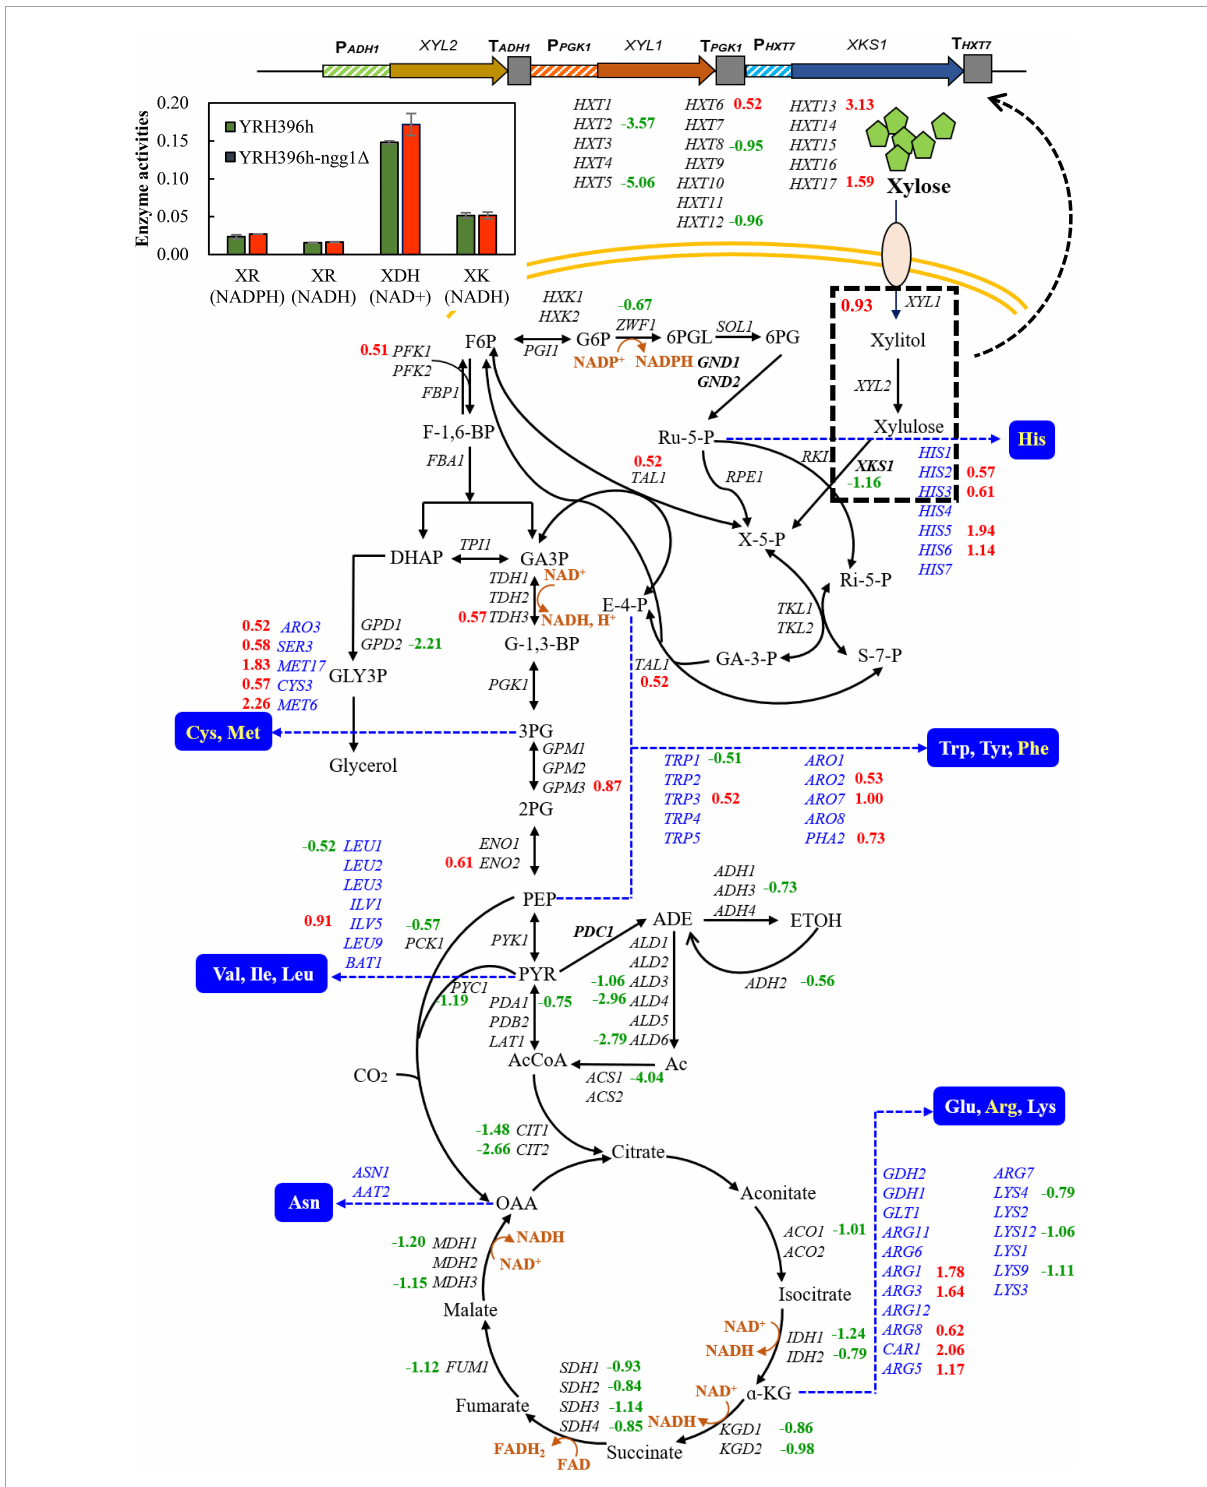
FIGURE4 Differentially expressed genes involved in carbohydrate and amino acids metabolism between YRH396h- ngg1 (cid:49) and YRH396h. Yeast strain with NGG1 deletion and its parent strain S. cerevisiae YRH396h were grown in YPX40 medium consisting of 4 g/L yeast exact, 3 g/L peptone, and 40 g/L xylose, and cells were collected at 48 h for transcriptome analysis. Genes involved in central carbon metabolism and amino acid biosynthesis were presented. The heterogenous xylose metabolism pathway containing XYL1 , XYL2 , and XKS1 as well as relative enzyme activities (XR, XDH, and XK) were also displayed in the upper left